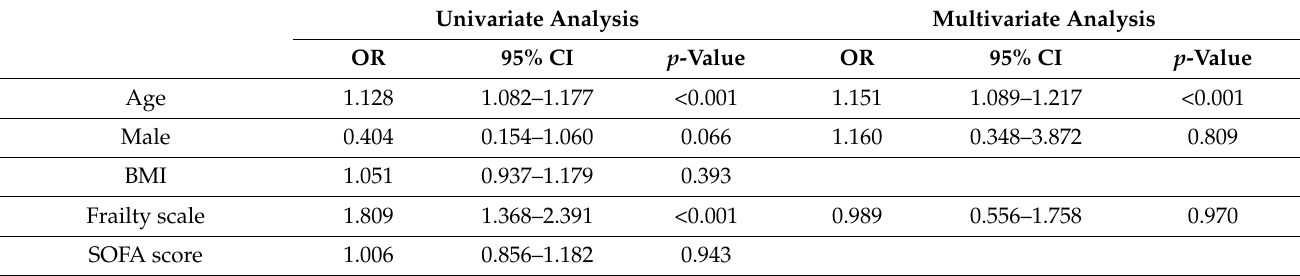
Table 4. Univariate and multivariate logistic regression analysis addressing the risk factors for in-hospital